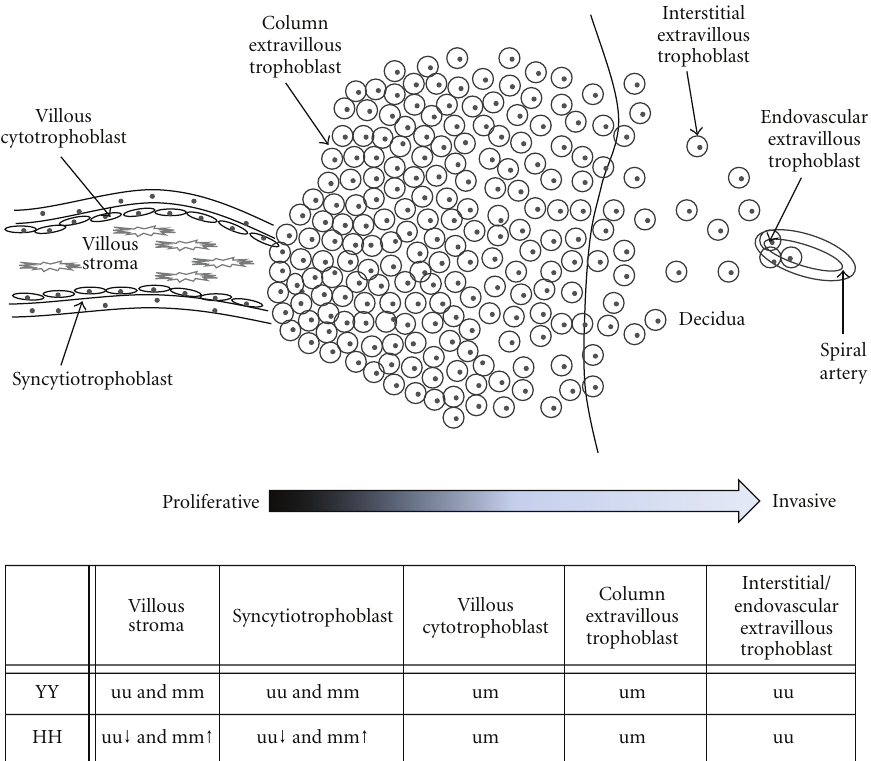
Figure 1: Model of a villus with an extravillous trophoblast column invading the maternal decidua . Below this model, showing di ff erent cell types within and originating from a villus, a table shows the STOX1 methylation pattern observed or hypothesized to be found in the di ff erent cell types. YY: placenta homozygous for the Y-allele; HH: placenta homozygous for the H-allele; uu: both alleles are unmethylated; mm: both alleles are methylated; um: imprinting (only one allele is